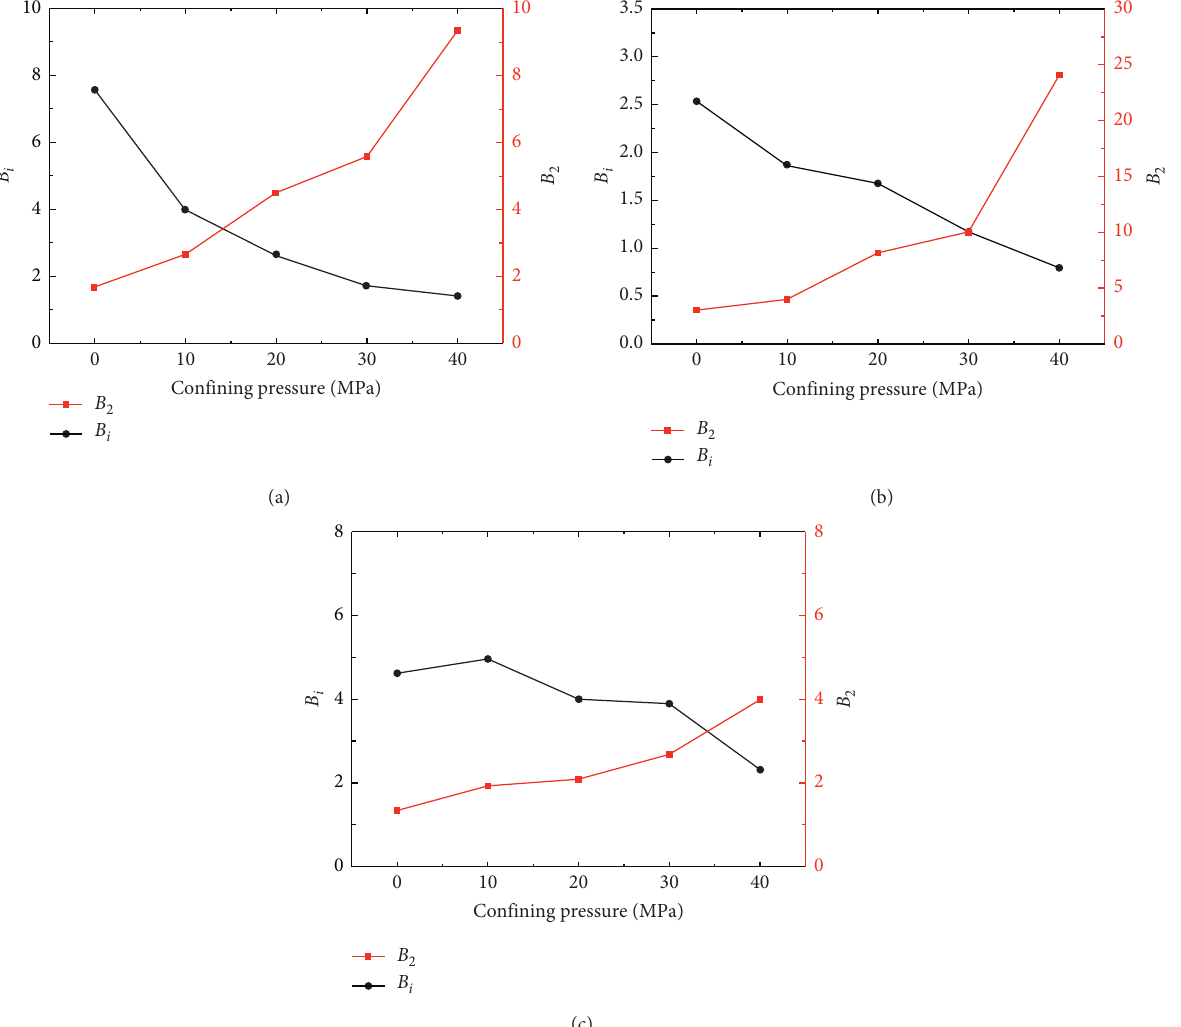
Figure 6: Variation tendency of B Spectrometer system and radio frequency unit